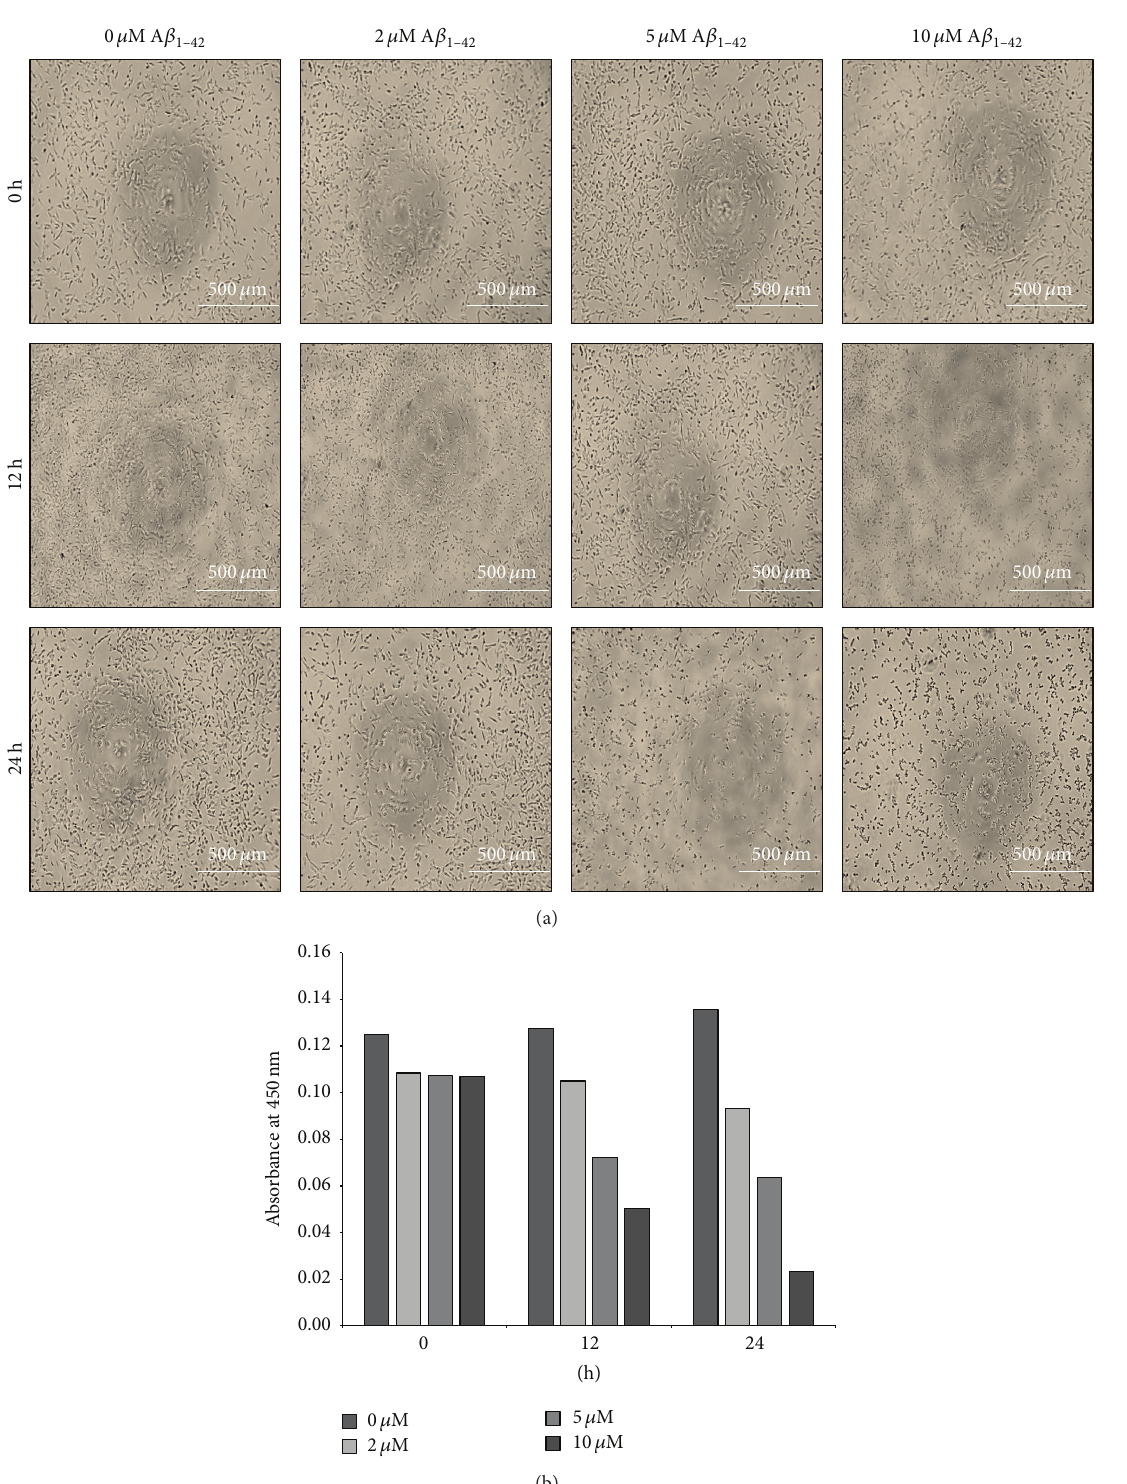
Figure 2: Exposure to A 𝛽 1 decreased the viability of SH-SY5Y cells in a dose- and time-dependent manner. (a) Phase contrast micrographs – 42 for different periods of time. (b) Cell viability as detected at 450 nm absorbance of SH-SY5Y cells treated with various concentrations of A 𝛽 1 – 42 (mean ±